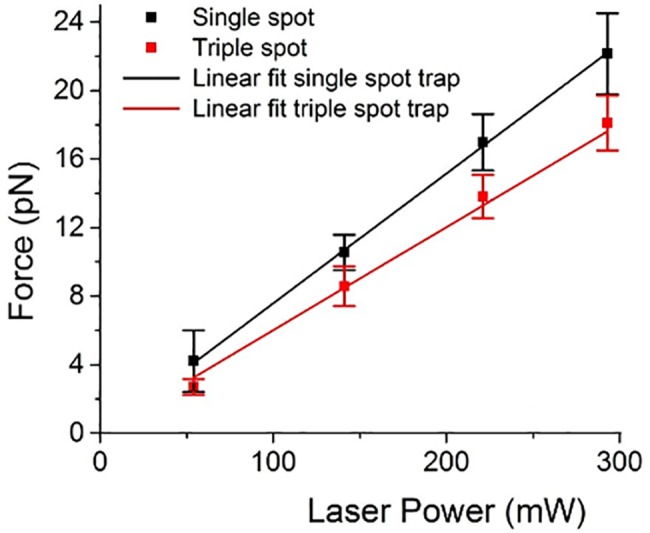
Laser beam power at the sample versus optical trapping force for a T-cell trapped using a single-spot (black squares) and triple-spot (red squares) trap.Trap depth was kept constant at 10 μm above the coverslip surface, and each point represents the mean ± standard deviation of 36 individual measurements.